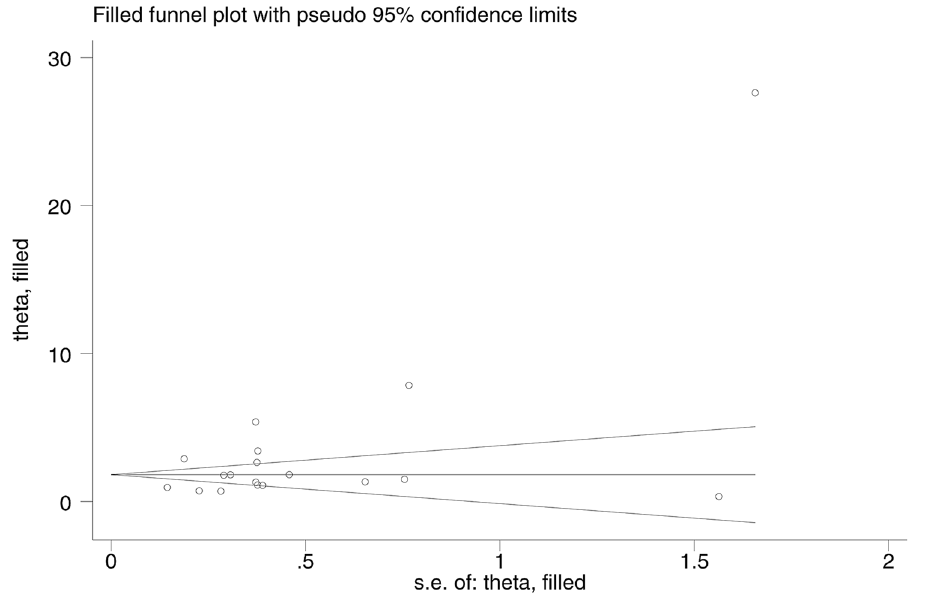
Figure 9. The funnel plot after trim-and-fill method was